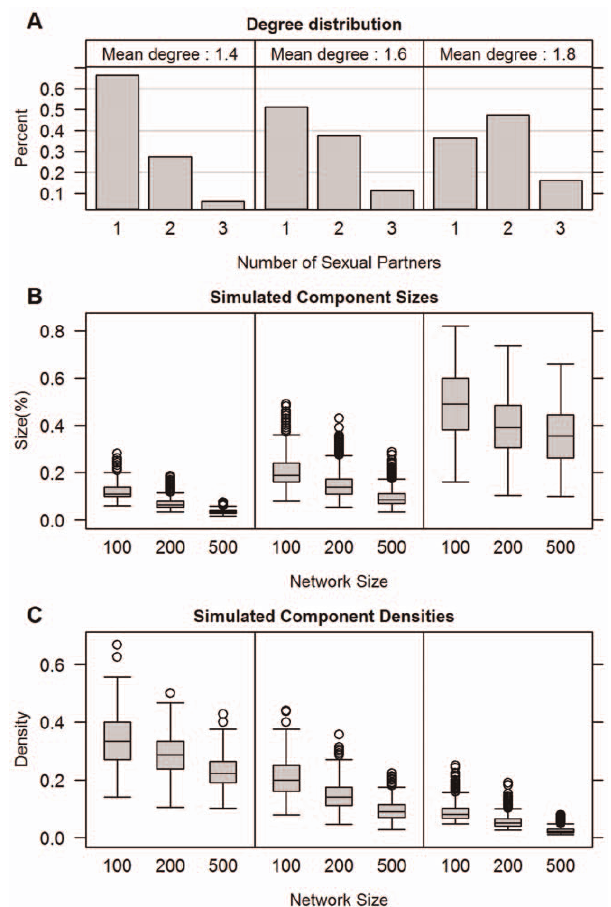
Figure 3. Distributions of the largest component size and density as a function of network size and concurrency: In this figure we reproduce some of the information in Figure 1 for networks of size 100, 200 and 500. The top row again shows histograms of the momentary degree distribution for networks at mean degrees around 1.4, 1.6 and 1.8, corresponding to concurrency prevalence of 35, 50 and 65%. The middle row shows the size distribution of the largest component as a percentage of the network, and the bottom row shows the distribution of the density of the largest components. Note that the percentage of the network in the largest component decreases with network size, but variability rises with concurrency levels. The density of the largest component decreases with network size and level of concurrency.